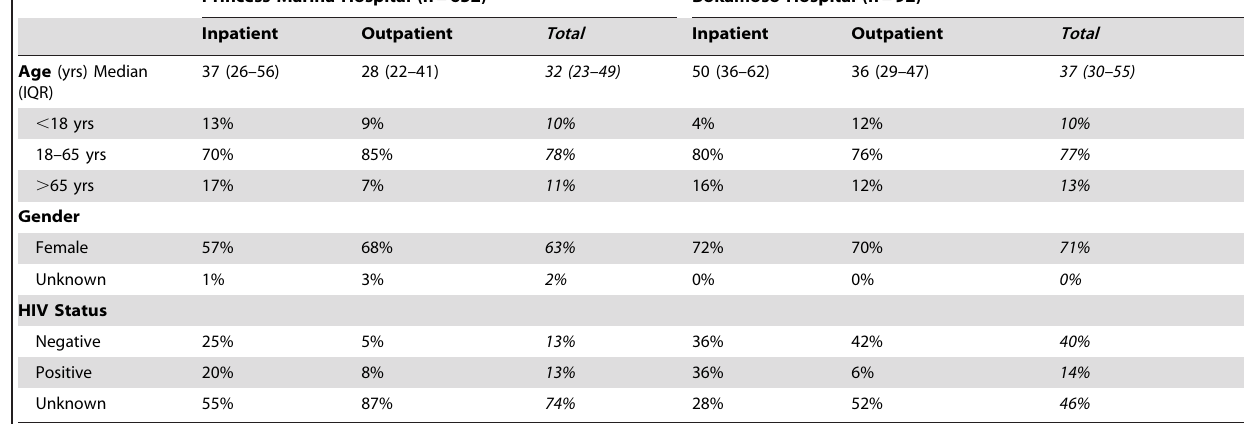
Table 1. Patient Demographics.